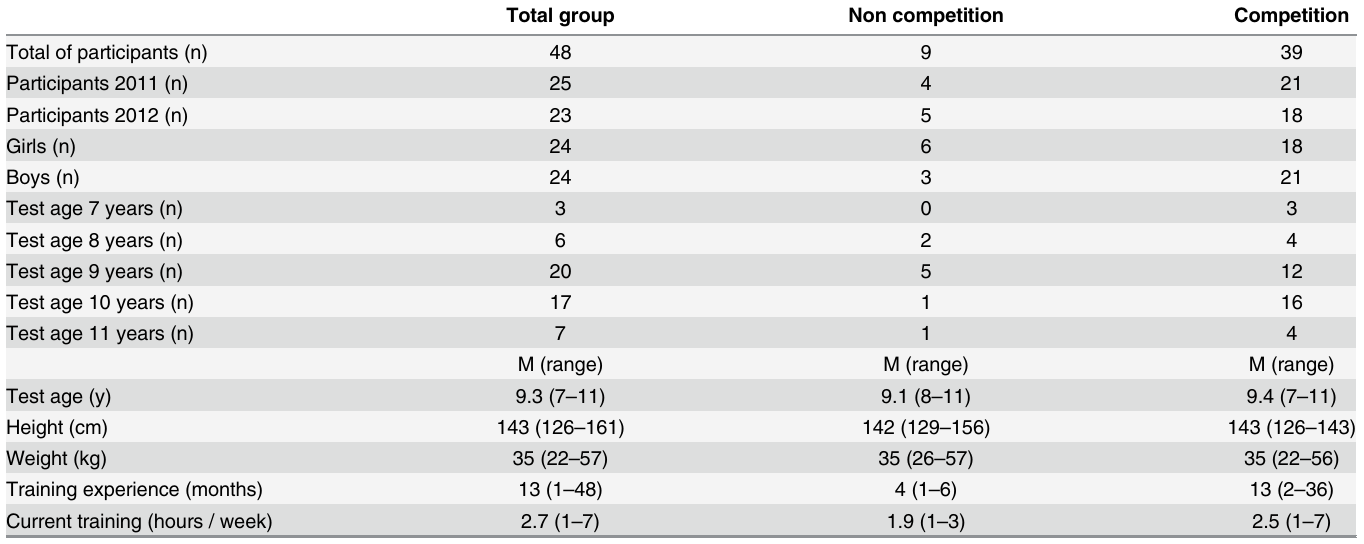
Table 1. Characteristics of participants.